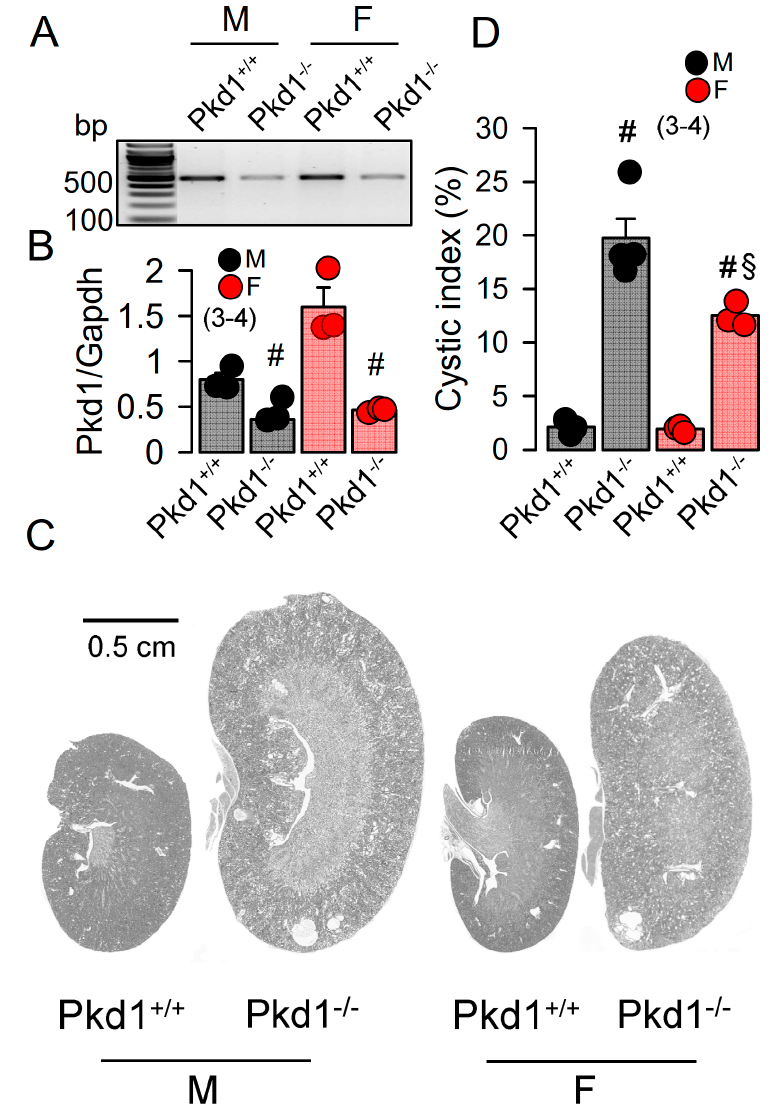
Figure 1. Renal cysts in male and female PKD1-knockout mice. ( A , B ) RT-PCR of Pkd1 in renal primary epithelial cells from male (M) and female (F) Pkd1 +/+ and Pkd1 − / − mice, and semiquantitative analysis of expression. ( C ) HE staining of whole kidneys and analysis of renal cysts by stitching microscopy. Male Pkd1 − / − kidneys had larger sizes when compared to kidneys from female Pkd1 − / − mice. ( D ) Cystic index in male and female Pkd1 +/+ and Pkd1-/- kidneys. Mean ± SEM (number of animals in each series). # significant difference when compared to Pkd1 +/+ ( p < 0.05; unpaired t-test). § significant difference when compared to male ( p < 0.05; ANOVA with Tukey’s post-hoc test).